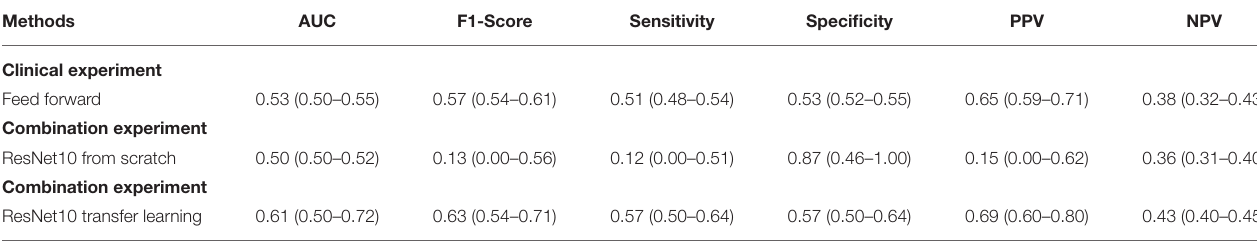
TABLE 5 | Results of all experiments from the deep learning approach for predicting good reperfusion (post-eTICI ≥ 2b).